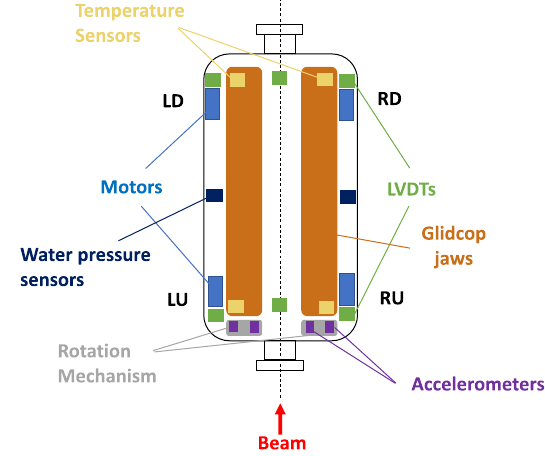
FIG. 13. Schematic overview of the rotatable collimator proto- type showing the sensors installed for the HiRadMat beam damage tests.